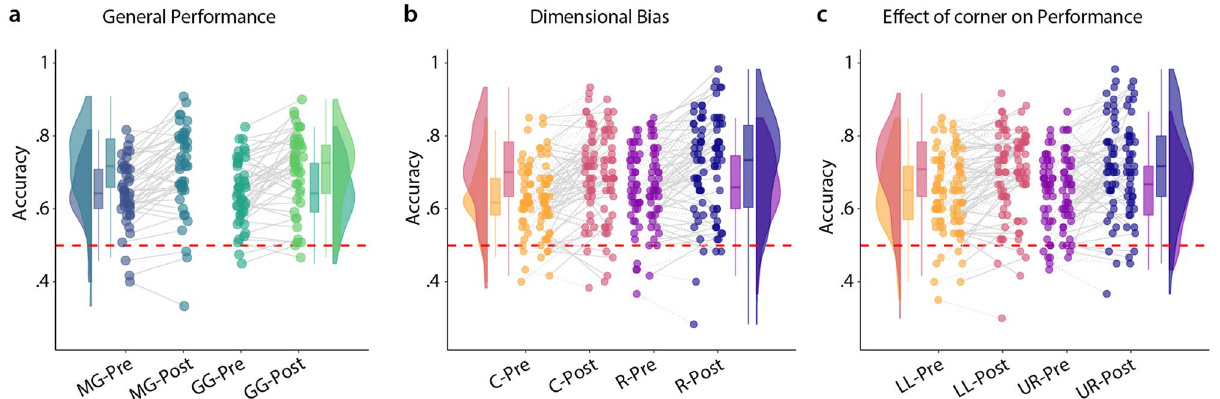
Figure 7. Results from the forced choice task investigating dimensional bias and corner. ( a ) General performance split into the movement group and the gamepad group as well as pre and post. We found a main effect of time point, but no group effect. ( b ) Illustration of dimensional bias analysis. Box plots and violin plots contain the data from both groups, scatter points are split into two columns: on the left the movement group on the right the gamepad group. We found a slight advantage for rectangles (R) over circles (C) but no interaction effects and no main effect of group. ( c ) Illustration of performance in the lower left (LL) and upper right (UR) corner of the space in pre and post. Corners of the space refer to the positions in the quantity space in a Cartesian coordinate system: lower left as low values both along the X- and Y-dimension (few circles and rectangles) while upper right refers to high values in the X- and Y-dimension (many circles and rectangles). Again, density and bar plots contain data from both groups while scatter points are organised in columns (the movement group on the left, the gamepad group on the right). We found a main effect of time point but no other